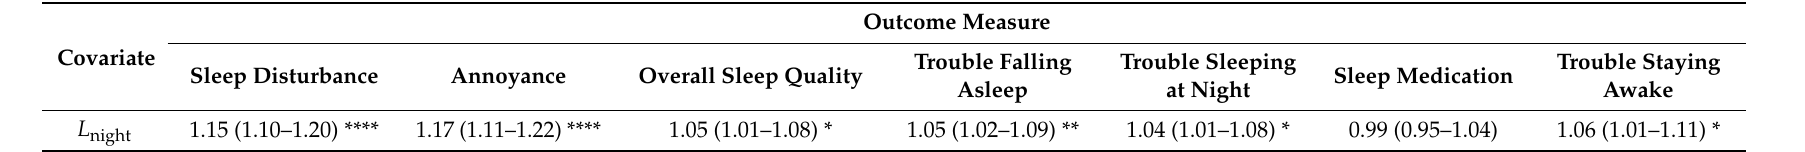
Table 2. Odds ratios and 95% confidence intervals from unadjusted logistic regression models for sleep quality variables. Covariate Sleep Disturbance Annoyance Overall Sleep Quality